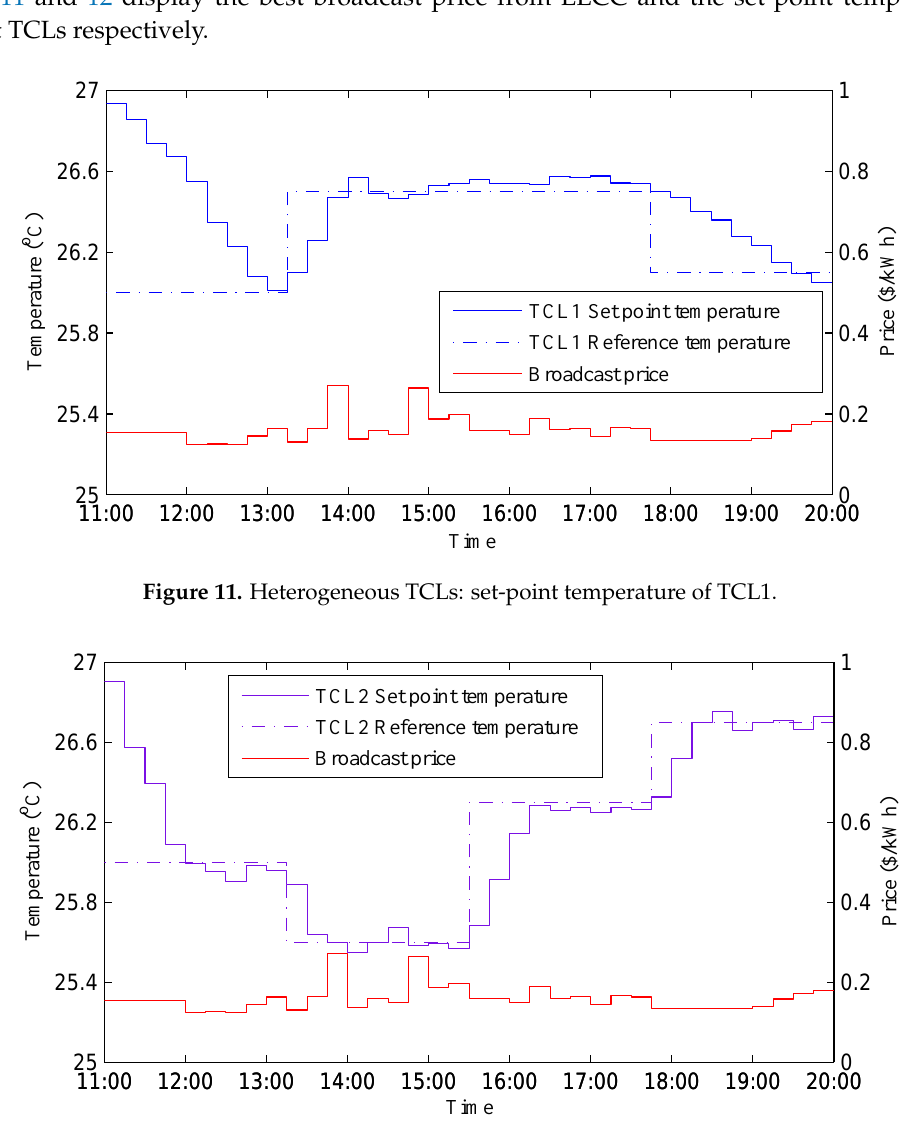
Figure 12. Heterogeneous TCLs: set-point temperature of